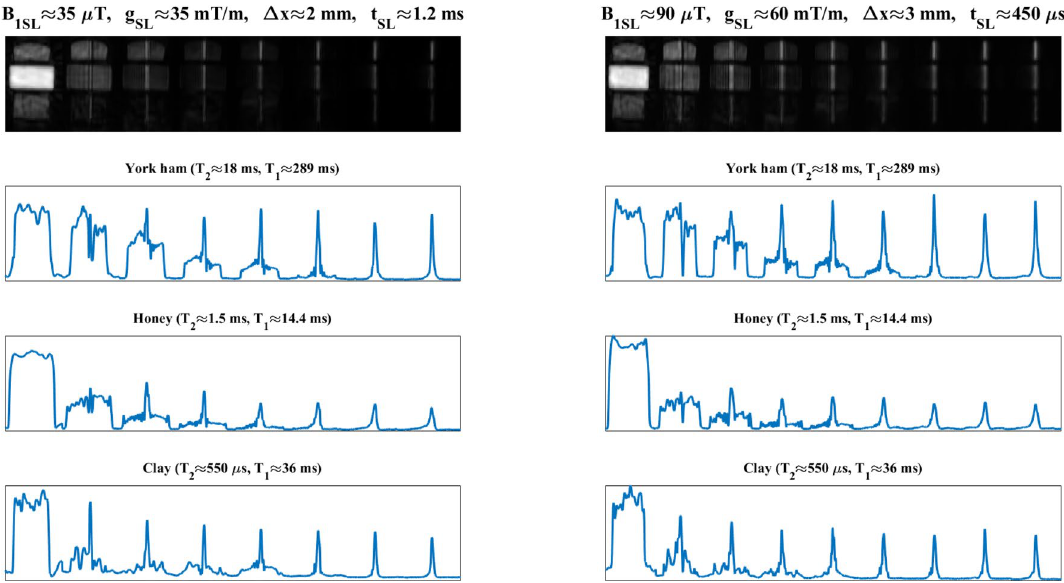
Figure 3. Evolution of the slice selection process as a function of t SL for a structured ‘phantom’ with York ham, honey and clay. The T 1 and T 2 times for the samples at 0.26 T are indicated above the corresponding 1D profiles on the three bottom rows, which correspond to the central lines of the samples in the top row images. The slice selection process is depicted for two different sets of SL parameters: g SL ≈ 35 mT/m and B 1SL ≈ 35 µ T (left); and g SL ≈ 60 mT/m and B 1SL ≈ 90 µ T